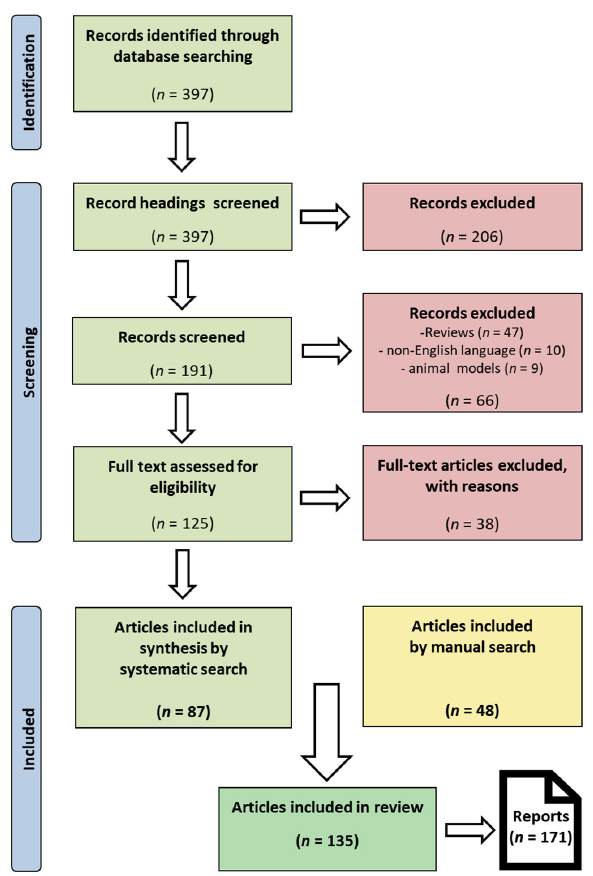
Figure 1. PRISMA (Preferred Reporting Items for Systematic Reviews and Meta-Analyses) flow diagram illustrating the literature search strategy: It maps the number of records identified, screened, included as well as excluded with respective reasons, conforming to PRISMA guidelines available at http://prisma-statement.org. This systematic search was complemented by 48 manuscripts identified through manual search of review type articles and back searches from reference lists of included articles, resulting in 135 articles in total, containing 171 reports on HIPEC